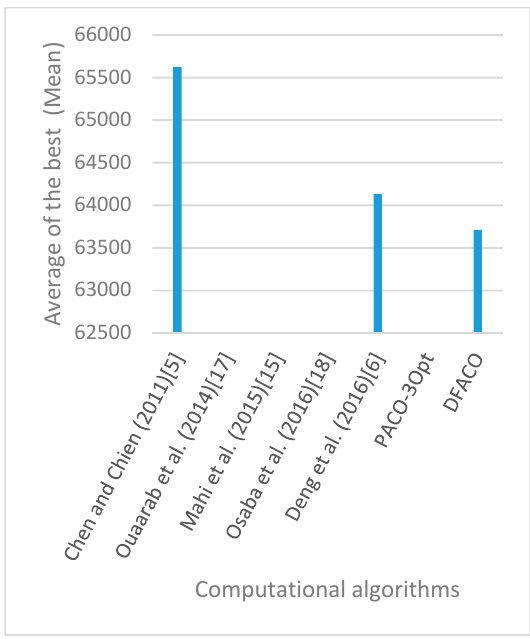
Figure 31. Average of best solutions obtained for instance d1655 by all algorithms.